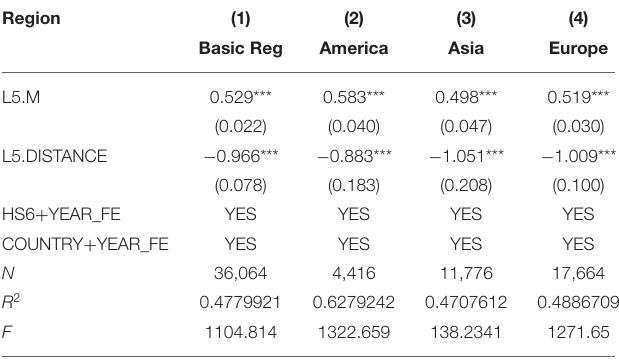
TABLE 4 | Model estimates of the effect of product distance on comparative advantage by region. Region